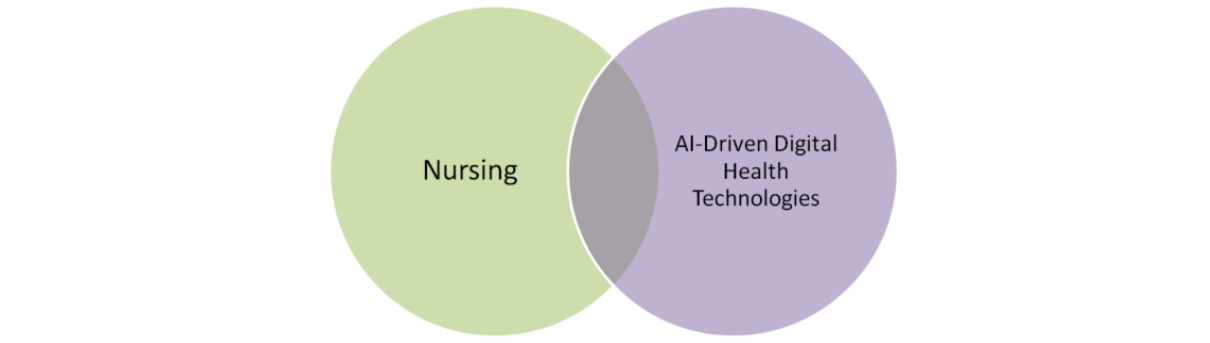
Figure 1. Main concepts explored in the